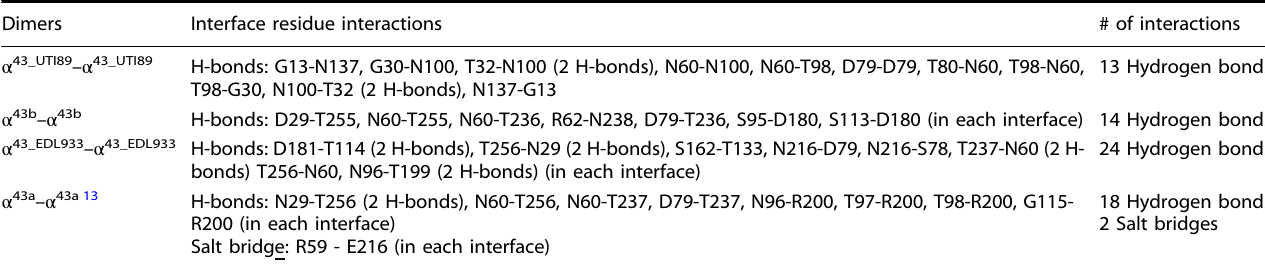
Table 2. List of residues involved in the Ag43 self-association interfaces.